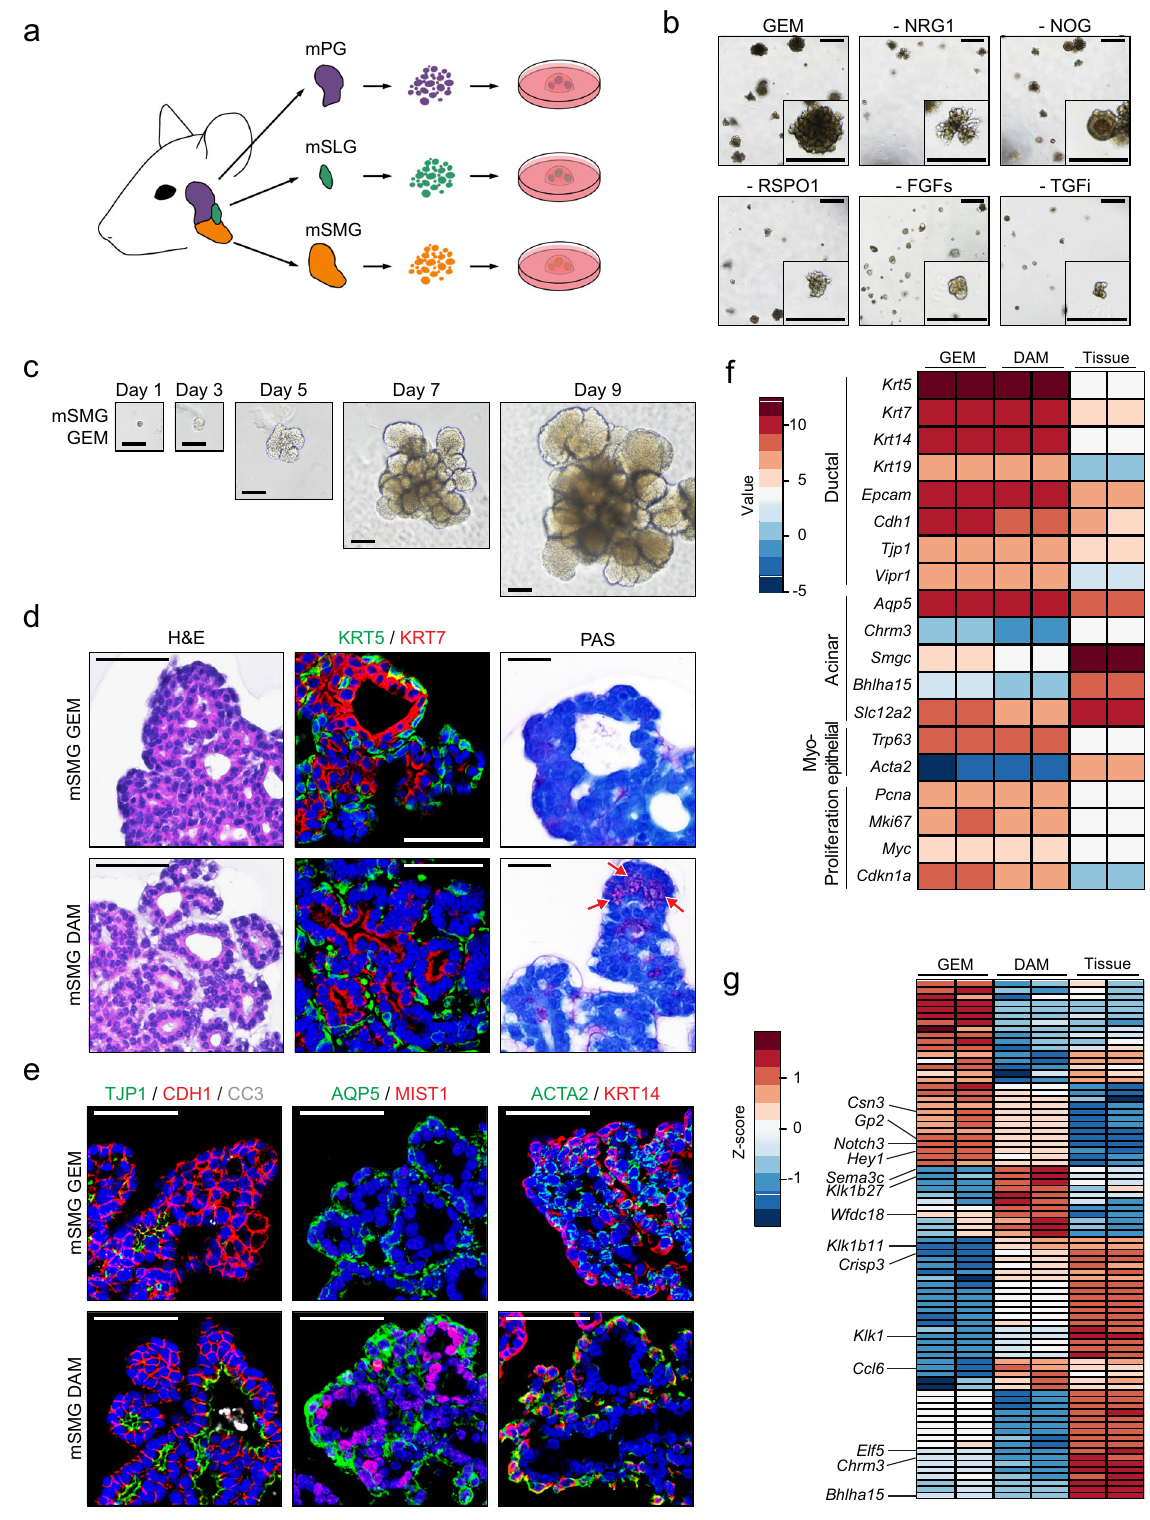
Crisp3 ) and SMG-speci fi c ( Sema3c, Klk1, Klk1b11 , and Klk1b27